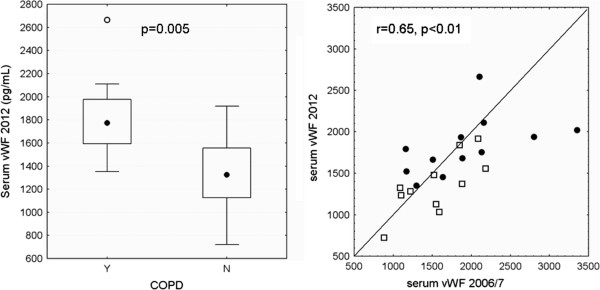
A significant difference between smokers with and without COPD for the level of serum VWF was shown in 2006/2007 and this difference was maintained in 2012 (left). The correlation between 2006/2007 and 2012 levels of VWF was significant (right). The data is shown for smokers with (circles) and without (open squares) COPD and with the line of identity.